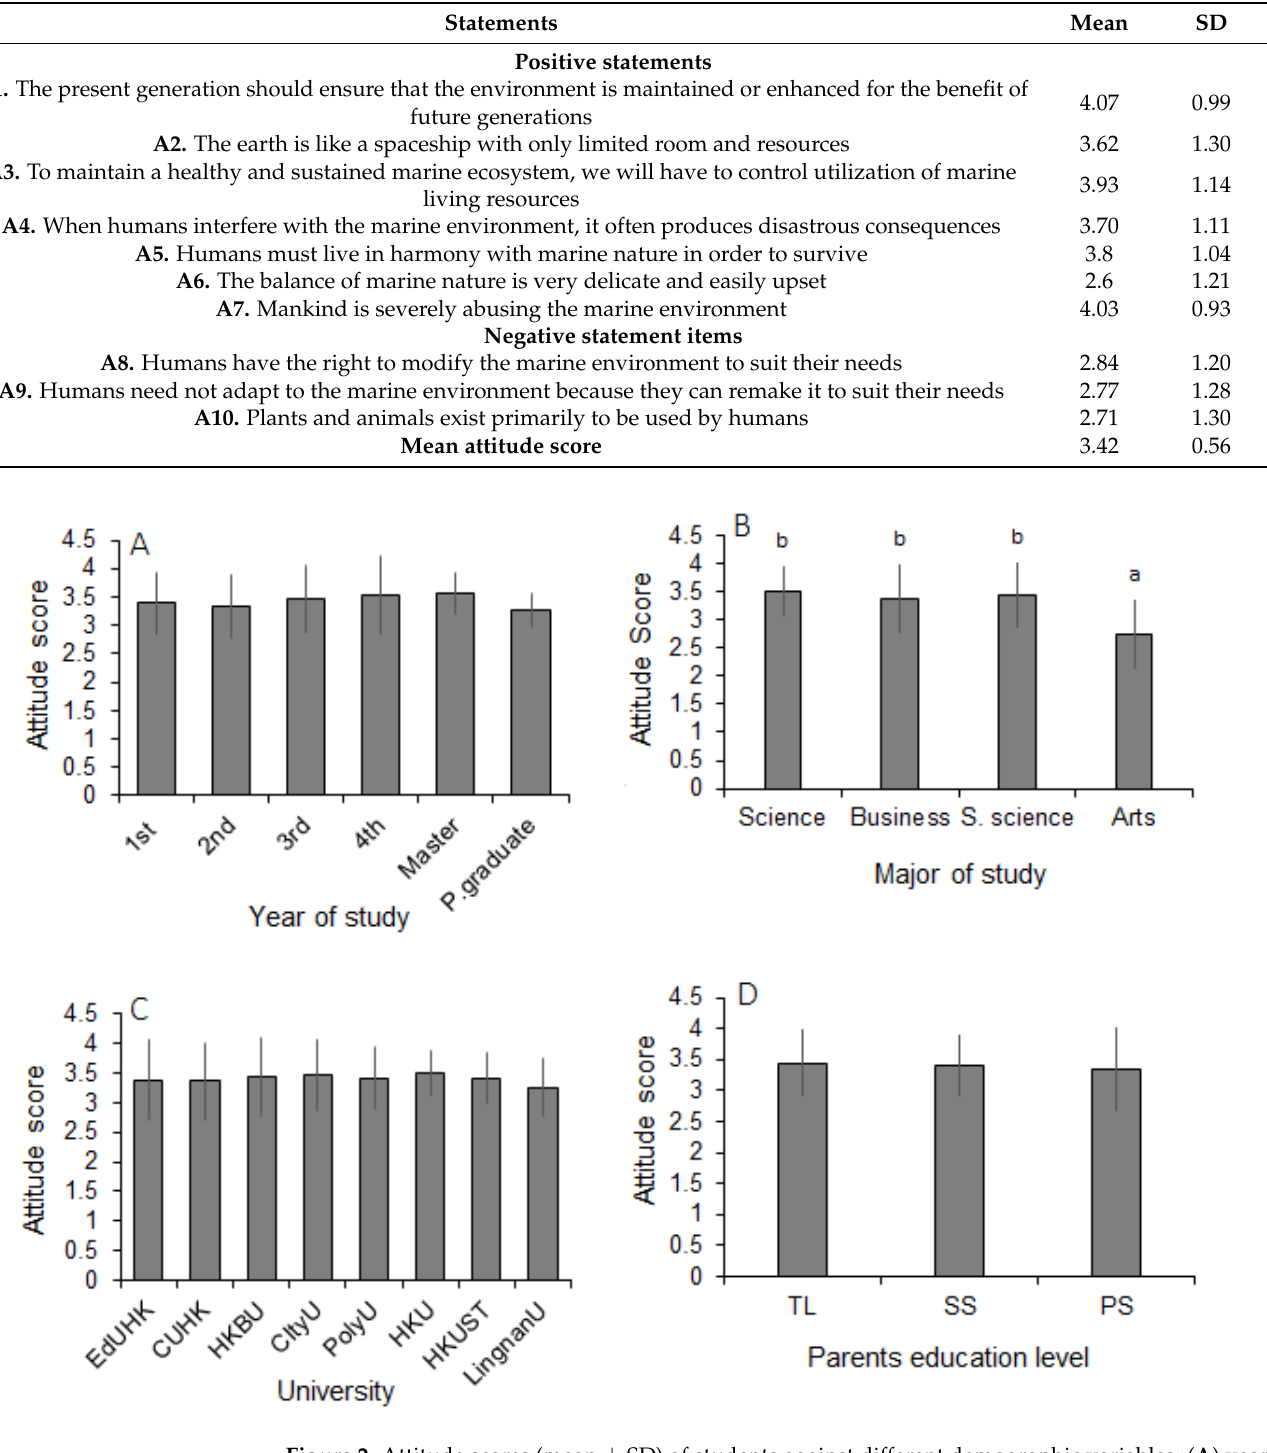
Figure 2. Attitude scores (mean ± SD) of students against different demographic variables: ( A ) year of study; ( B ) major of study; ( C ) major institution of study; ( D ) parents’ education level. Bars with different letters are significantly different (one-way post hoc LSD test; 95% level of confidence). TL = tertiary level of study, SS = secondary level of study, PS = primary level of study.